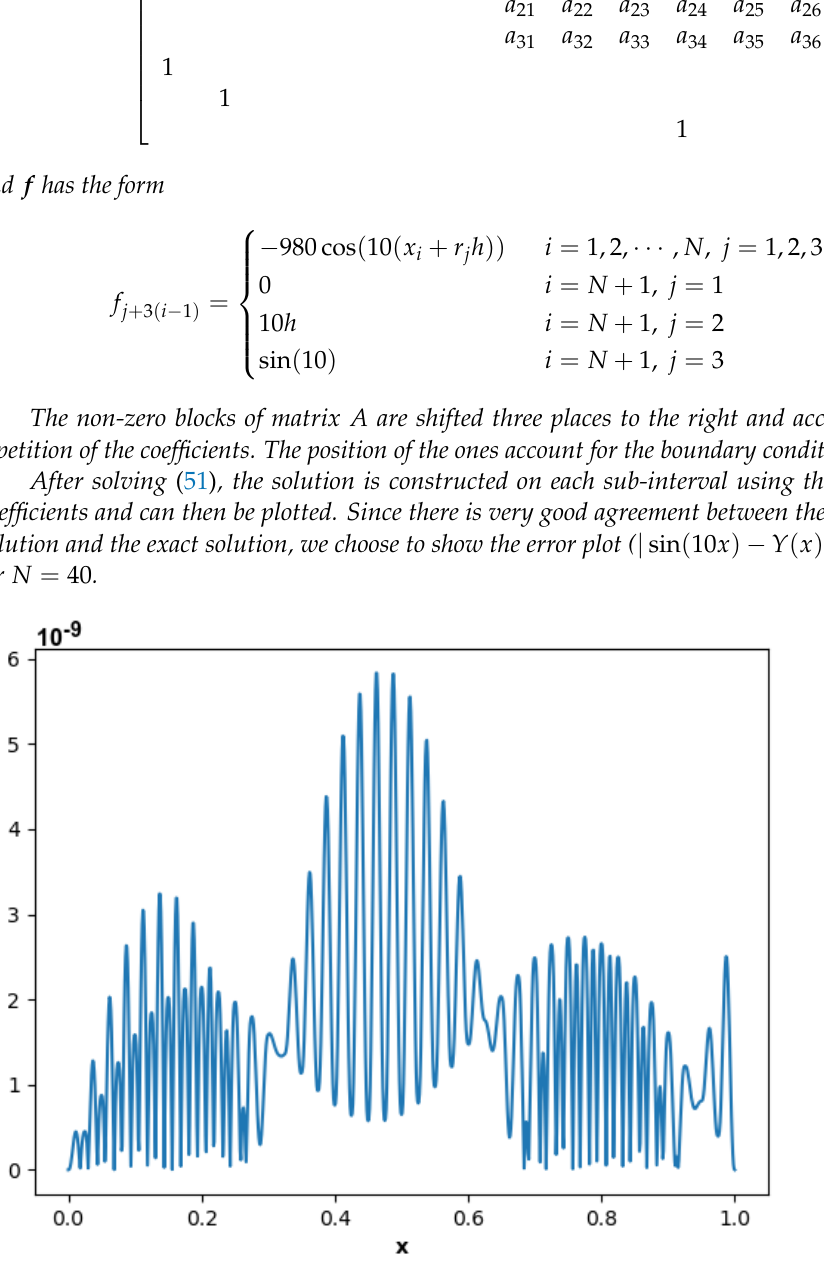
Figure 4. Error plot with N = 40 for Example